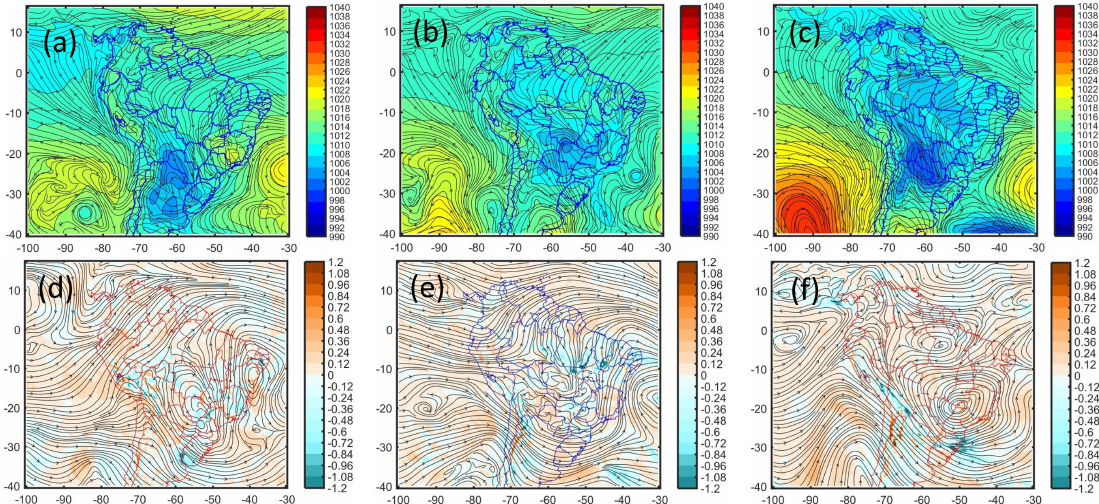
Figure 7. Composites of wind streamlines (m s − 1 ) and reduced pressure to mean sea level (hPa) at 1800 UTC (13 LT) for ( a ) TS1; ( b ) TS2 and ( c ) TS3. Cold colors indicate lower values and warm colors higher values. Composites of wind streamlines (m s − 1 ) and vertical velocities (Pa s − 1 ) at 300 hPa for ( d ) TS1; ( e ) TS2 and ( f ) TS3. Positive values indicate downdraft winds and negative values indicate updraft winds. All composites data were obtained from the NCEP-NCAR reanalyses (resolution: 0.5 ◦